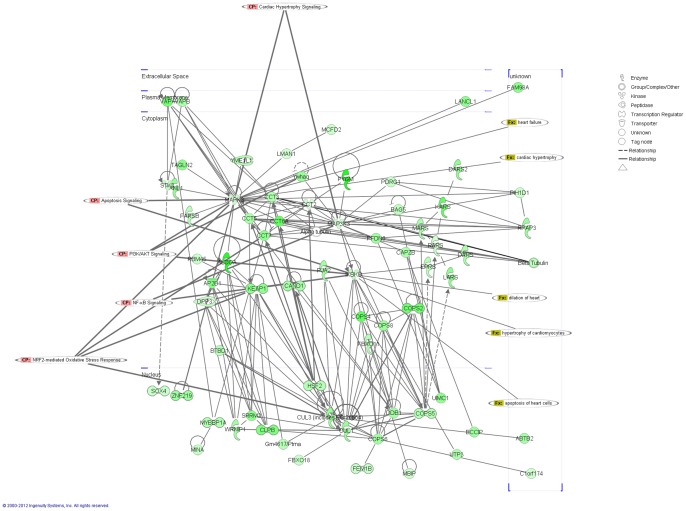
Most significant networks of SDRG associated with cardiac damage generated on the basis of the evidence stored in the IPA library.The top scoring networks identified as “Cardiovascular system development and function; cellular growth and proliferation; post-translational modification” (score 43, focus molecules 35), and “Cell death; cardiovascular system development and function; embryonic development” (score 38, focus molecule 33) were merged and overlaid for cardiovascular disorders.